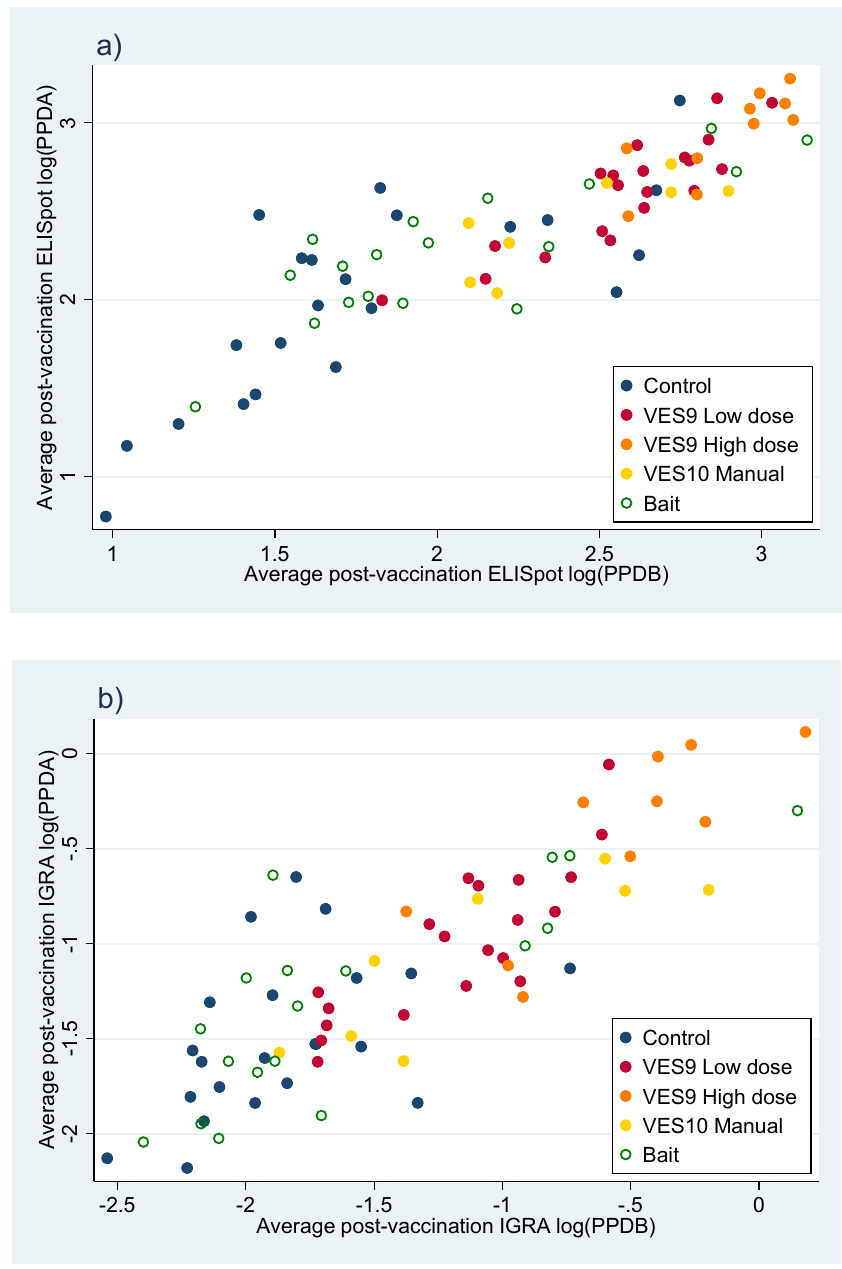
Figure 5. Measures of post-vaccination reaction to purified-protein derivative (PPD)A and PPDB measured by ( a ) enzyme-linked immune absorbent spot (ELISpot) assay and ( b ) IGRA, and transformed and summarised to PPDAm and PPDBm as described in the Methods. Each point summarises the post-vaccination state of one badger.